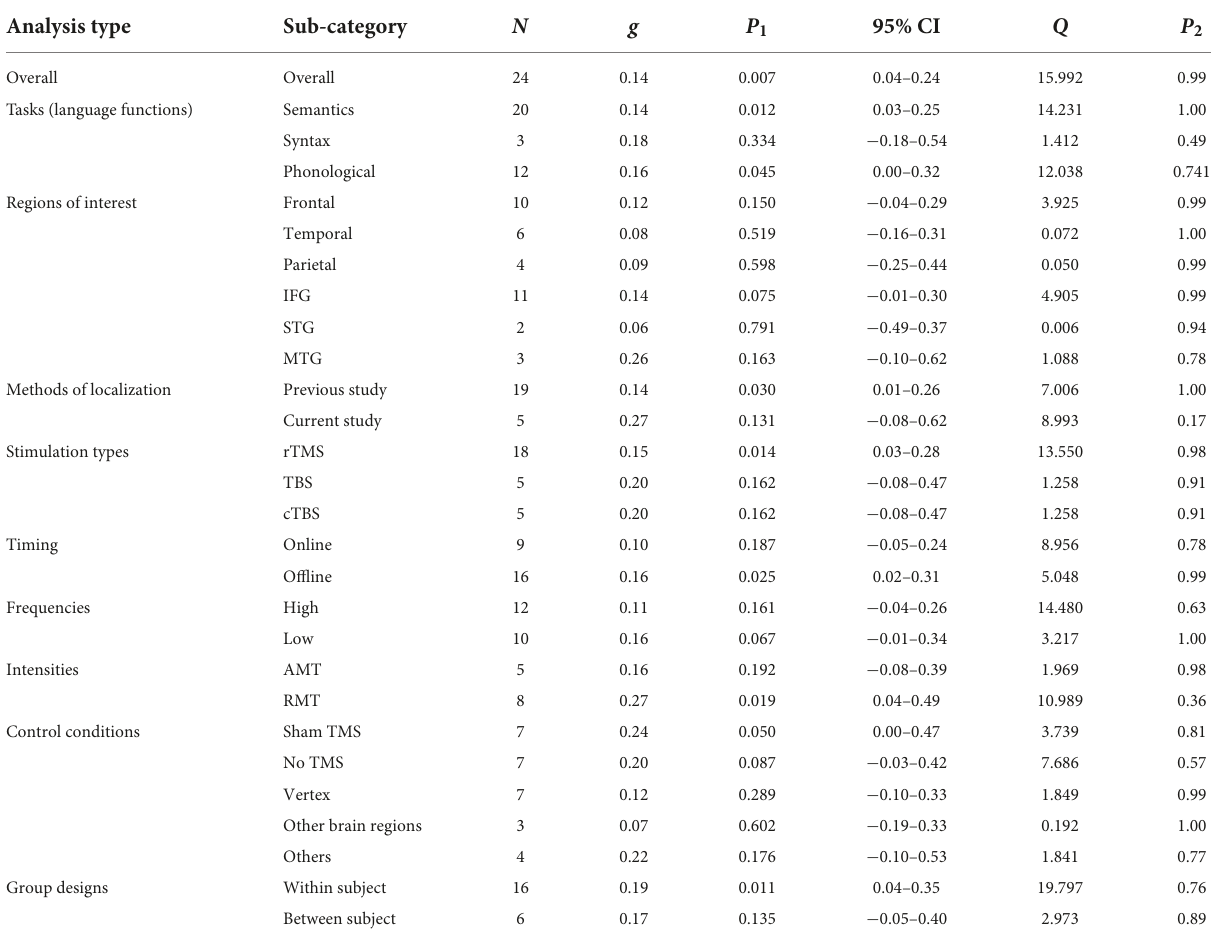
TABLE 4 Accuracy (ACC) results of overall effect analyses and moderator